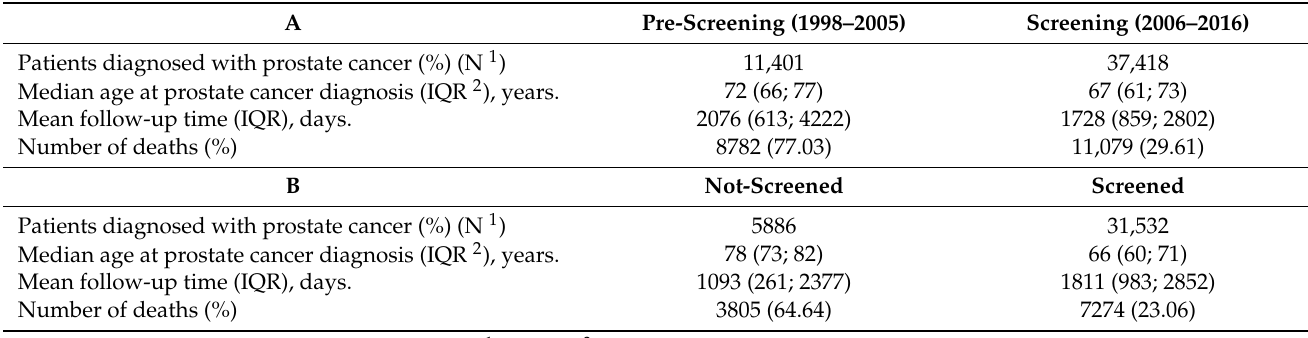
Table 1. Study group characteristics of men diagnosed with prostate cancer during pre-screening and screening period (A) and of screened and not-screened persons (B).